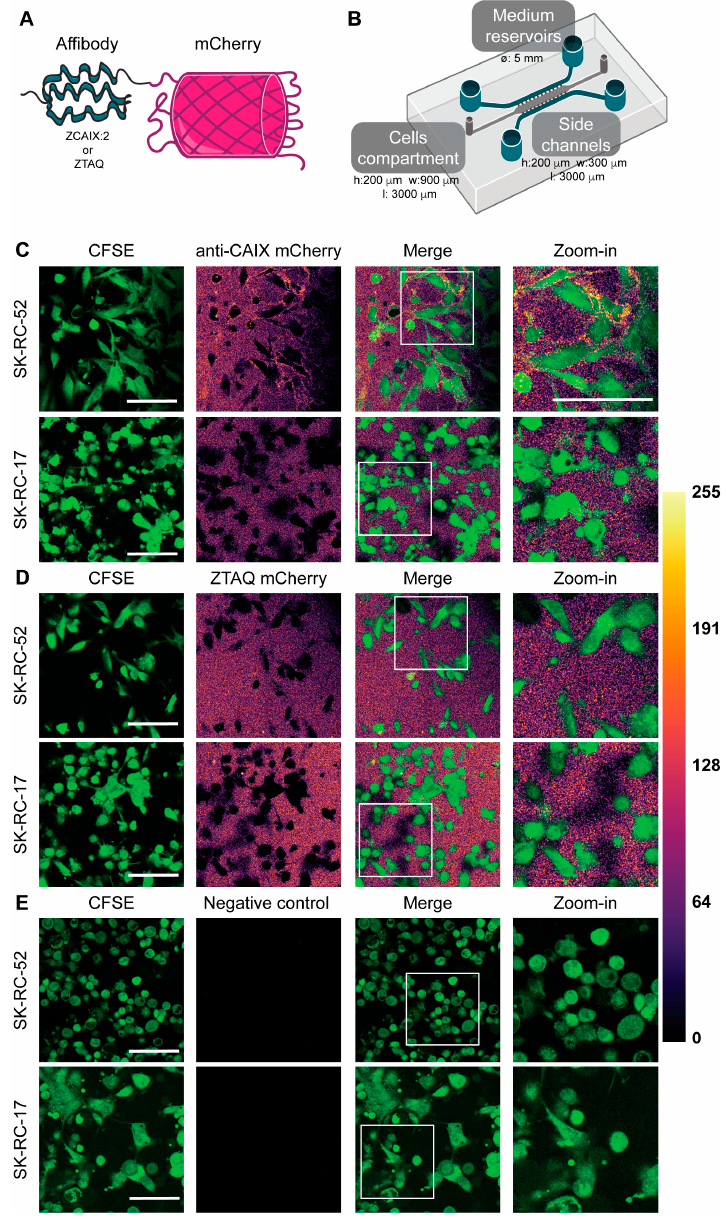
Figure 1. Affibody-mediated CAIX targeting on-chip. ( A ) Schematic representation of an affibody fused to mCherry. ( B ) Schematic representation of the microfluidic chip. ( C , D ) Confocal microscopy images of a tumor-on-a-chip after a one-hour incubation of CAIX-positive SK-RC-52 ( C ) or CAIX- negative SKRC-17 cells ( D ) with the anti-CAIX affibody-mCherry fusion or the ZTAQ affibody- mCherry fusion, which was used as non-binding control. ( E ) Medium only was used as a negative control to determine background fluorescence. The mpl-inferno LUT was used to depict the intensity in the mCherry channel. Scale bars represent 100 µ m. CFSE, carboxyfluorescein succinimidyl